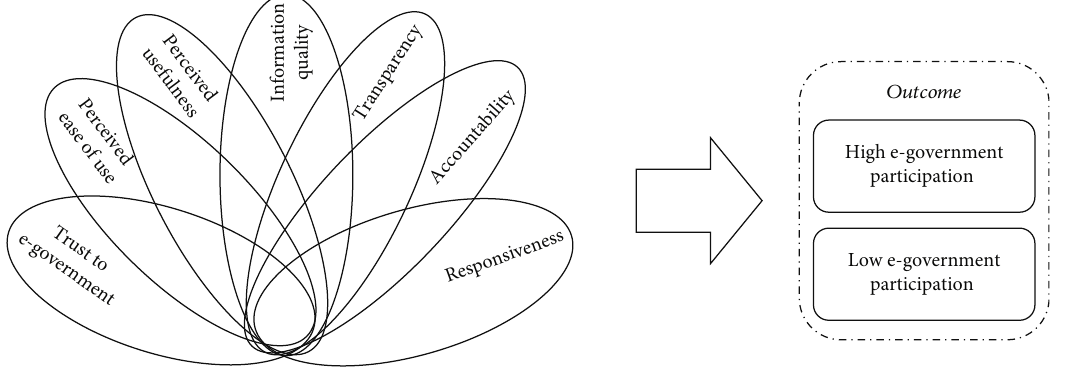
Figure 2: Illustration of asymmetrical